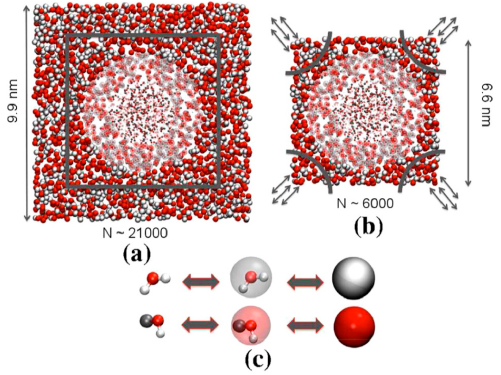
Figure 17. Simulations of a biomolecule dissolved in aqueous methanol: ( a ) Conventional AdResS approach; ( b ) PE-AdResS approach; and ( c ) Mapping scheme of the smooth transition between AA and CG representations. Reprinted with permission from Mukherji and Kremer [518]. Copyright 2016 American Chemical Society.